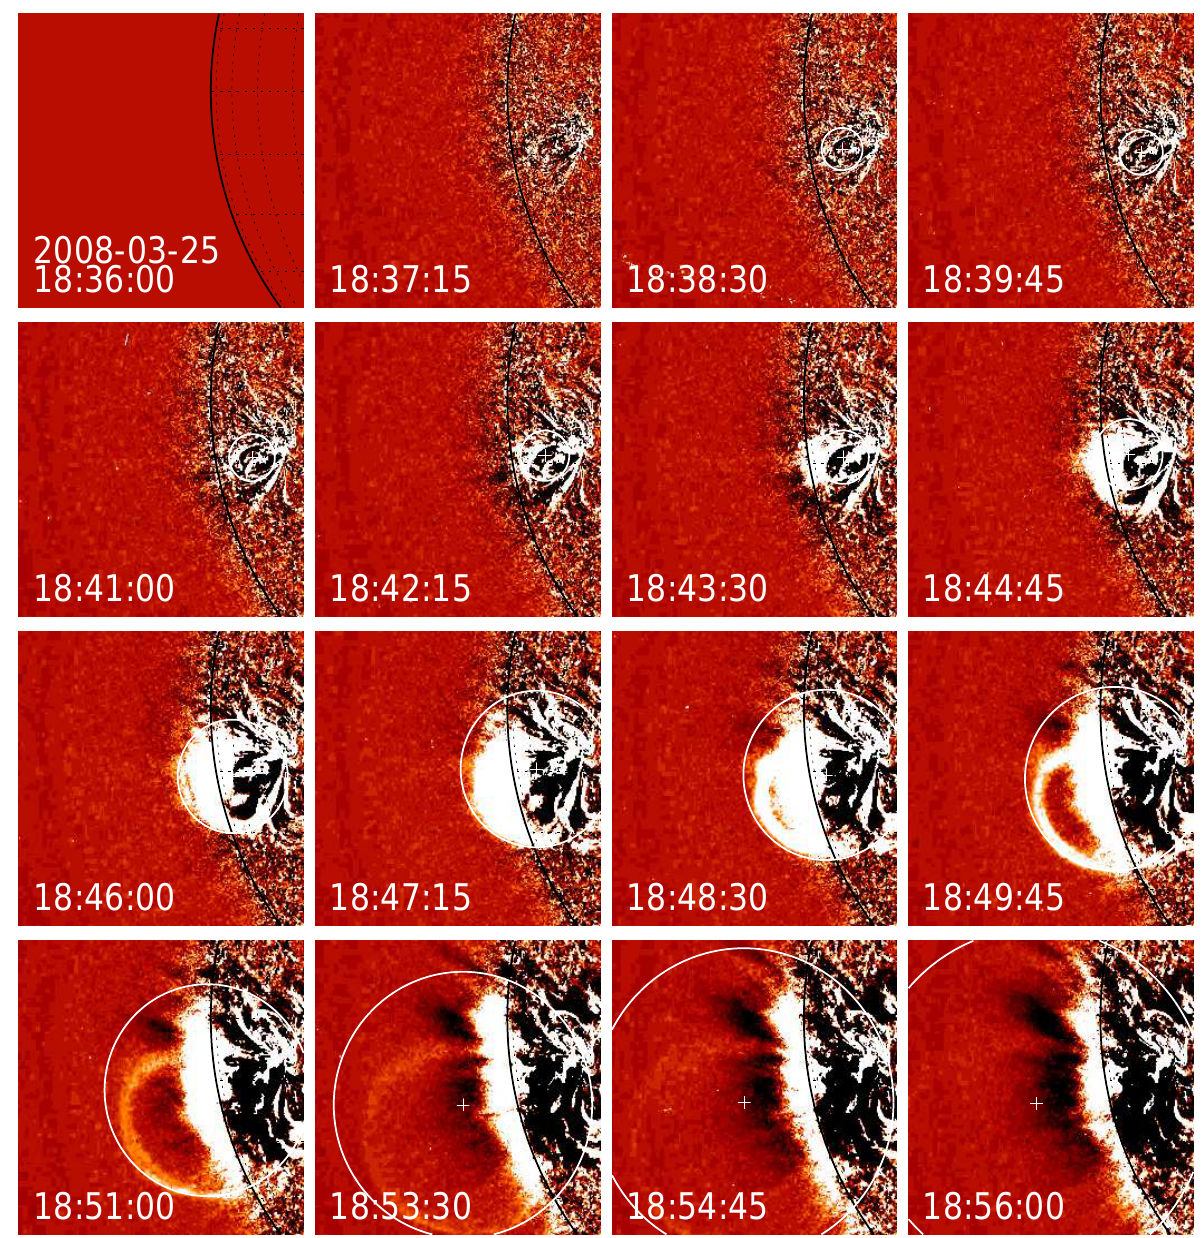
Fig. 3. EUVI base-difference images from STEREO/B 171 ˚A in similar representation as for STEREO/A in Fig. 2. Note that the CME origin is in the front of the solar disk in EUVI/B, while it is behind the east limb for EUVI/A.